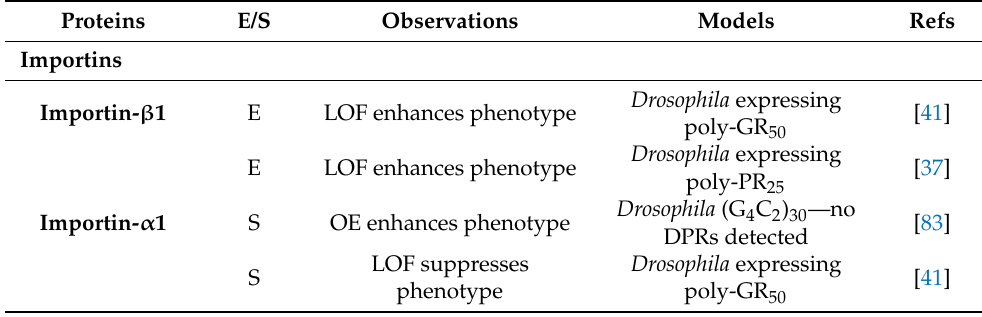
Table 3. Modifiers of toxicity. Summary of all the ALS-related models in which the effect of changing nucleocytoplasmic transport proteins on the different phenotypes was determined. S indicates suppressors. A protein is defined as a suppressor when a loss of function (LOF) suppresses the phenotype, a gain of function (GOF) enhances the phenotype or overexpression (OE) enhances the phenotype. E indicates an enhancer. A protein is defined as an enhancer when a LOF enhances the phenotype, a GOF suppresses the phenotype or OE suppresses the